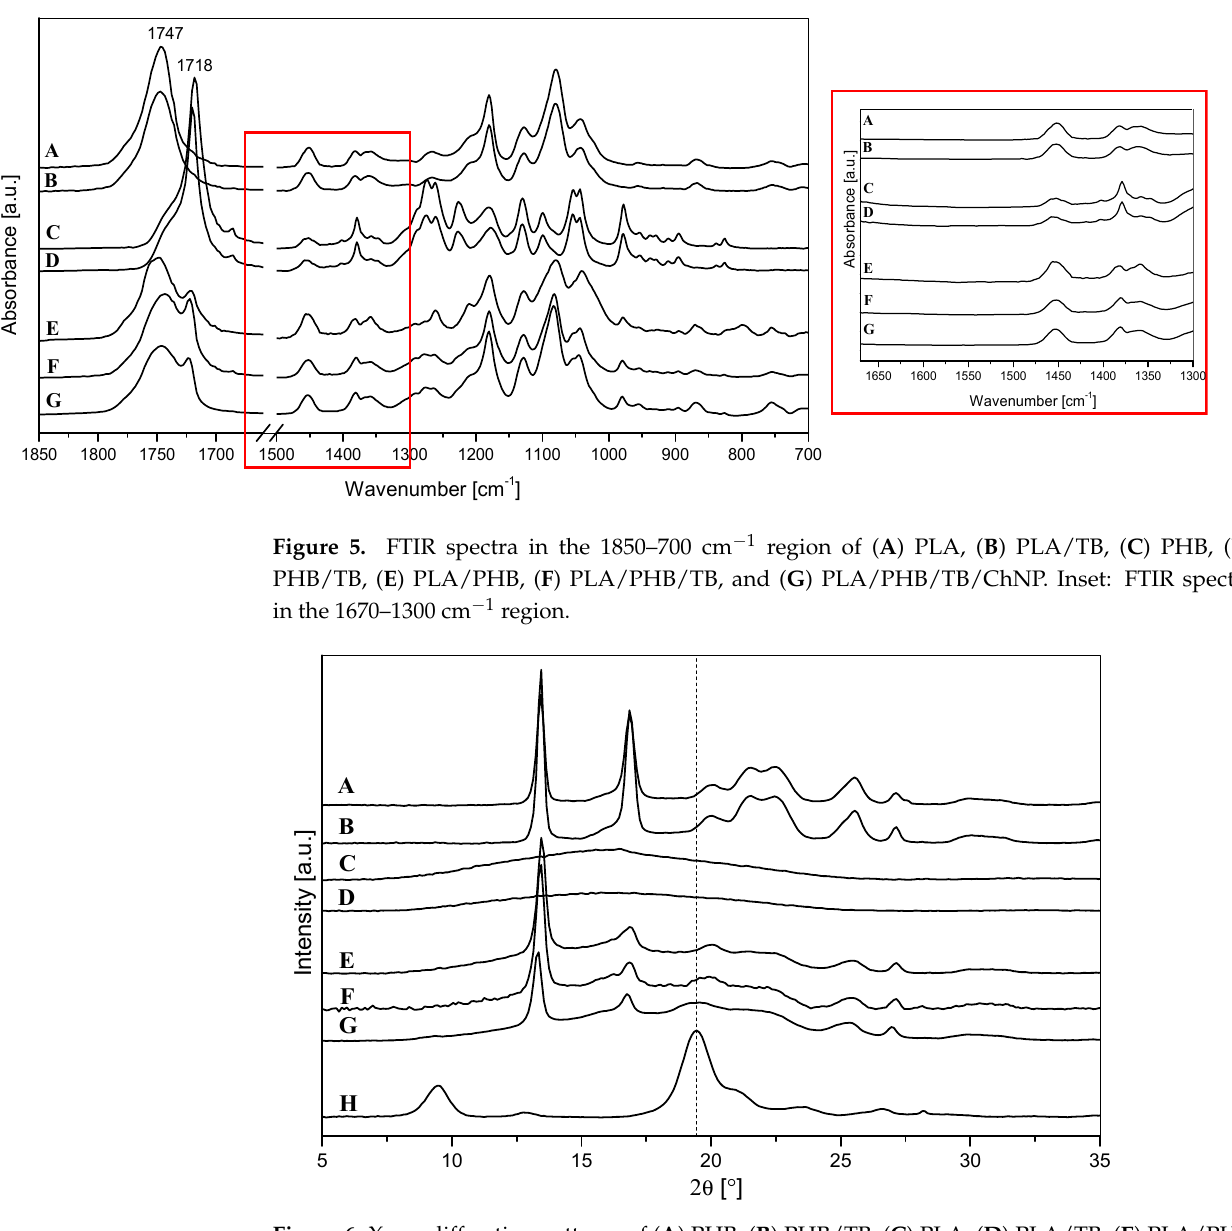
Figure 6. X-ray diffraction patterns of ( A ) PHB, ( B ) PHB/TB, ( C ) PLA, ( D ) PLA/TB, ( E ) PLA/PHB, ( F ) PLA/PHB/TB, ( G ) PLA/PHB/TB/ChNP, and ( H ) ChNPs.